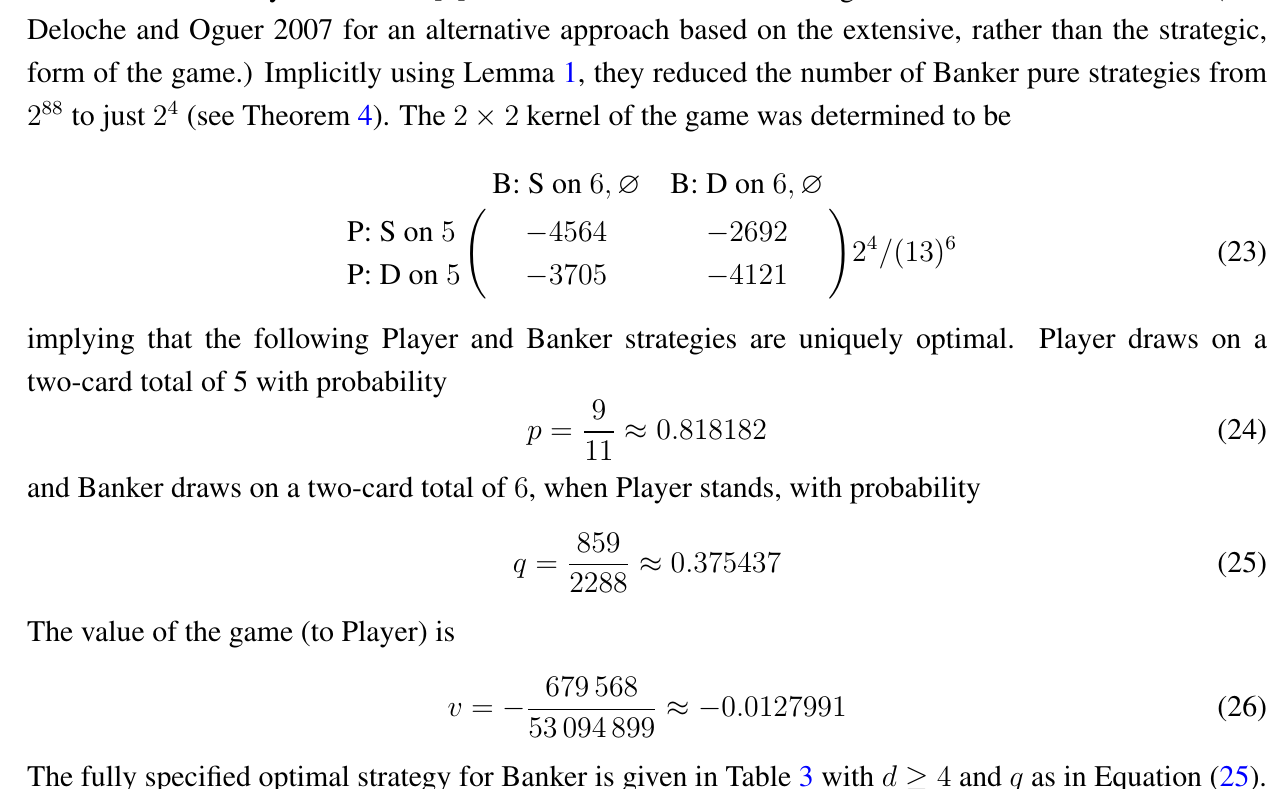
Table 3. Banker’s optimal move (final version) under Model B1 with d being a positive integer, indicated by D (draw) or S (stand), or ( S , D ) (stand with probability 1 probability q ). Here q is as in Equations (33) and (34). Under Model A1, results are the